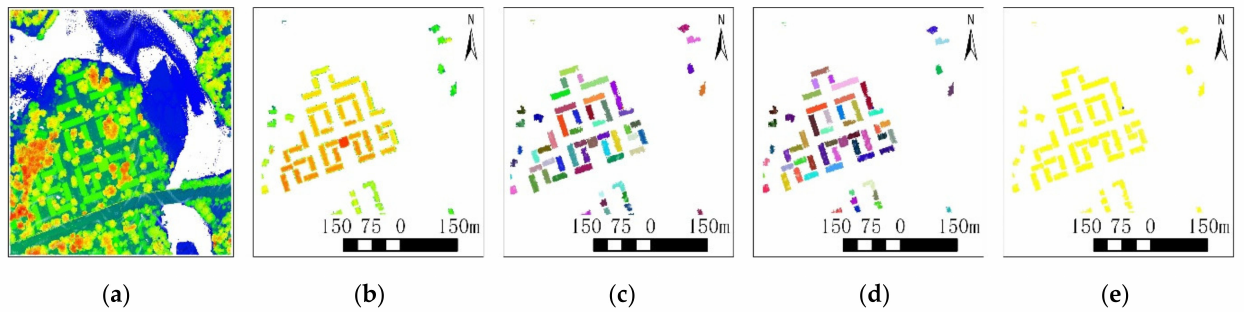
Figure 11. Building instance segmentation result of dataset 4: ( a ) The point clouds of the entire scene displayed in different colors according to their heights; ( b ) the building point clouds; ( c ) the result of UBIS method; ( d ) the ground truth; ( e ) the main differences between the UBIS method result and the ground truth.